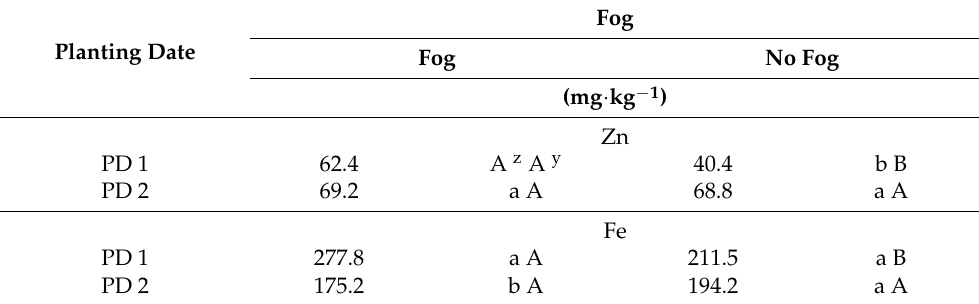
Table 4. Interaction between fogging and planting date (PD) for foliar zinc (Zn) and iron (Fe) concentrations on a dry weight basis in high tunnel-grown lettuce ‘Salanova Red Butter’.